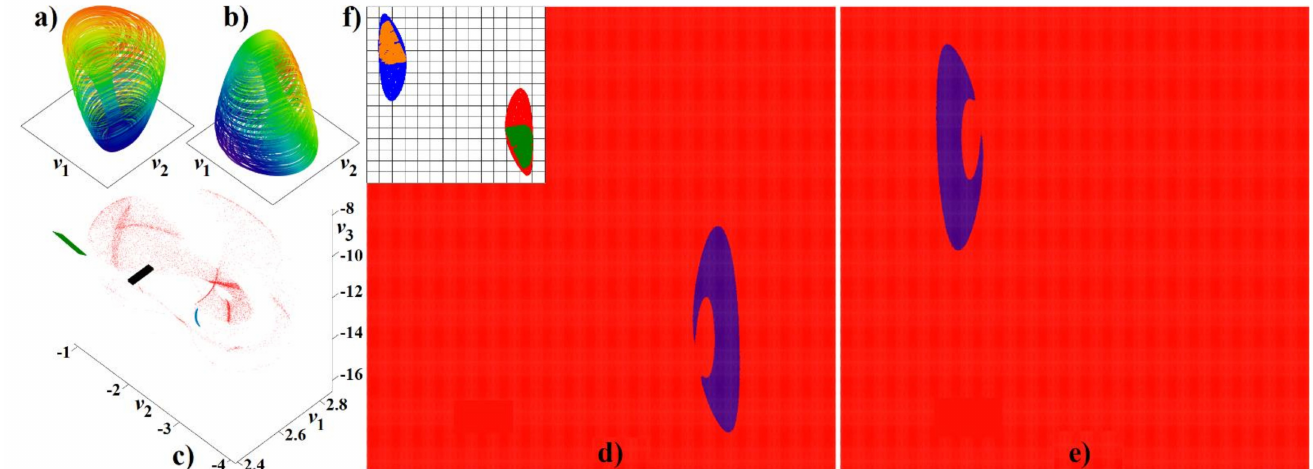
Figure 7. Cascoded resonant amplifier analyzed as third order dynamical system: ( a ) turbulent chaotic attractor evolved for the initial conditions x 0 = (2.3, 3, 8) T , ( b ) mirrored attractor for initial − − conditions x 0 = ( 2.3, 3, 8) T , ( c ) system sensitivity to changes of initial conditions (see text for details). − Basins of attraction for both mirrored strange attractors: ( d , e ), unbounded solution is marked by red color, evolution toward the strange attractor is denoted by blue color. Mutual position between mirrored attractors: ( f ). For further details, consult corresponding paragraph in main